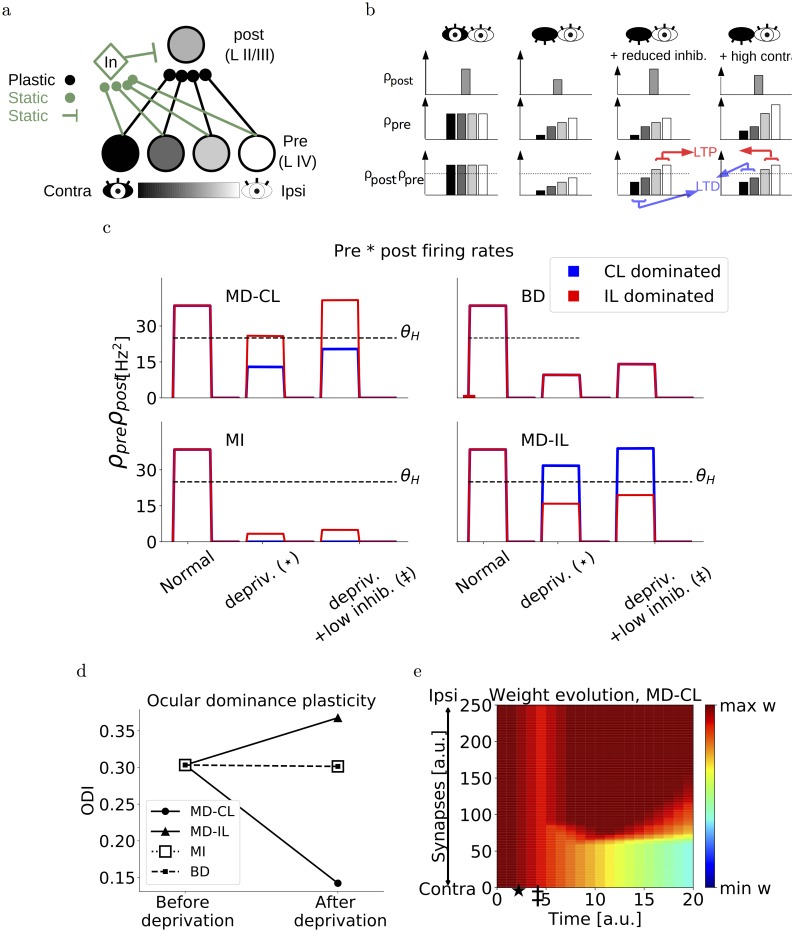
Single-threshold model.(a) Schematic of the model. One postsynaptic neuron receives inputs from a population of presynaptic neurons, each with different ODI. We use a grey-scale color scheme where darker colors denote contralateral-eye dominated neurons and brighter colors denote ipsilateral-eye dominated neurons. (b) Schematic of pre- and postsynaptic firing rates under normal rearing (left), monocular deprivation of the contralateral eye (second from left), monocular deprivation with a reduced inhibition (second from right) and monocular deprivation with high contrast inputs (right). The bottom row depicts the product between pre- and postsynaptic firing rates, and the threshold θ separating LTD from LTP. (c) Example traces of the product of presynaptic and postsynaptic firing rates of the neurons during monocular deprivation of the contralateral eye (MD-CL), binocular deprivation (BD), monocular inactivation of the contralateral eye (MI) and monocular deprivation of the ipsilateral eye (MD-IL). For red and blue traces, the product is taken with the most contralaterally dominated and ipsilaterally dominated presynaptic neuron respectively. (d) Ocular dominance index of the postsynaptic neuron at the beginning of the simulation versus the end. (e) Evolution of synaptic weights over time, in the case of monocular deprivation of the contralateral eye. The star denotes the onset of deprivation, the double dagger denotes the onset of reduced inhibition. Corresponding neuronal activations are shown in panel c.